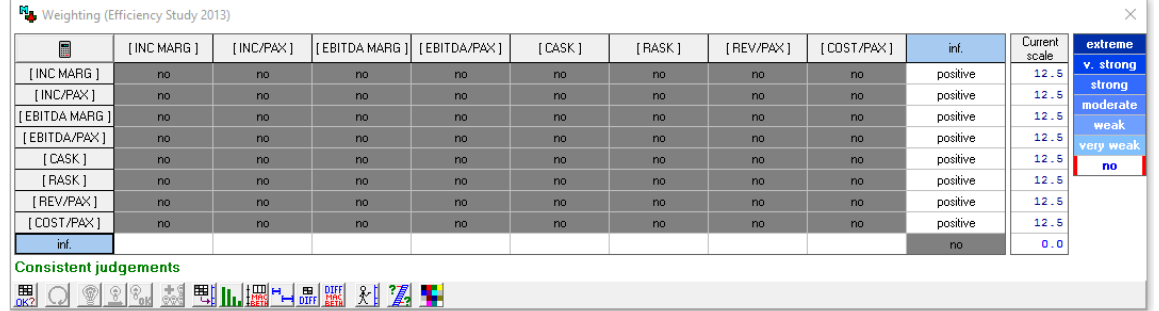
Figure 13: Ponderation (Weighting) Table.